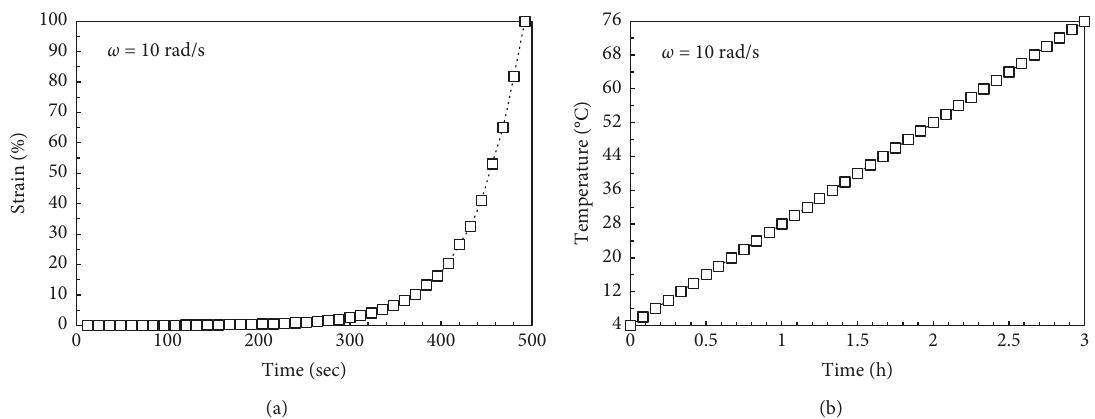
Figure 3: Preliminary test configuration: amplitude sweep (a) and temperature sweep (b)